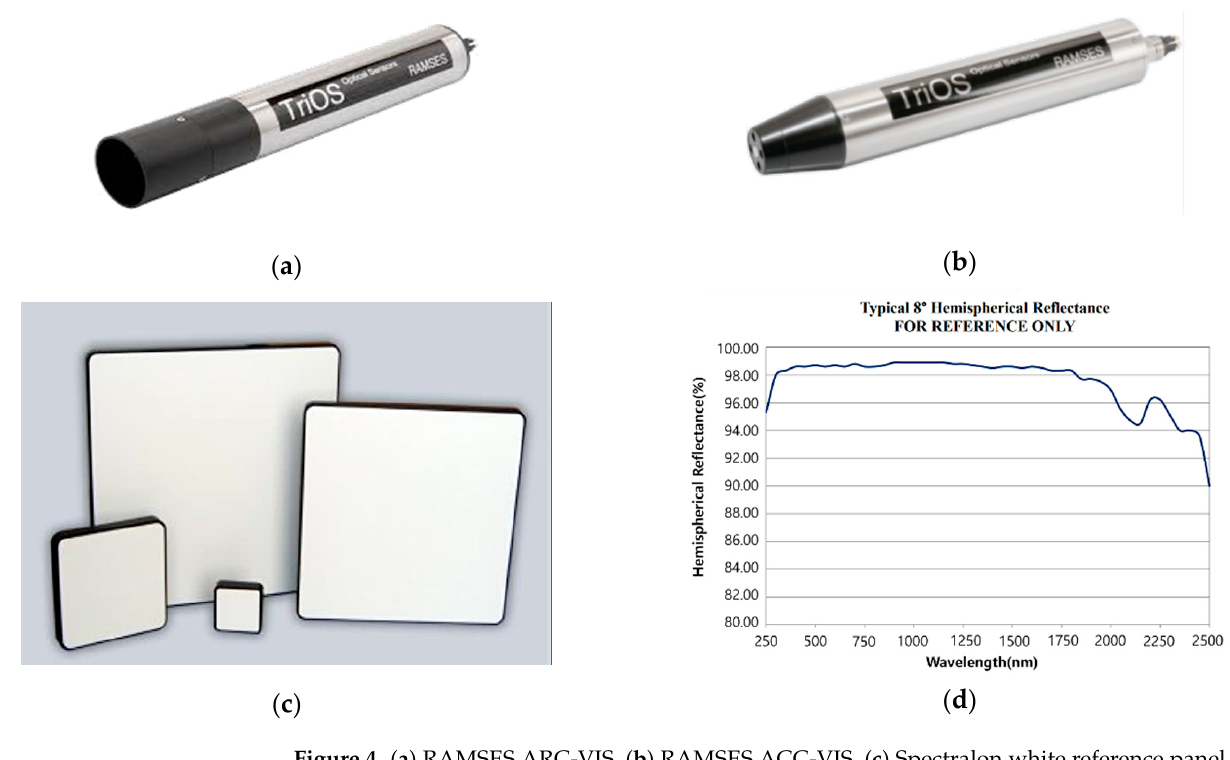
Figure 4. ( a ) RAMSES ARC-VIS, ( b ) RAMSES ACC-VIS, ( c ) Spectralon white reference panel, and ( d ) reflectance of the white reference panel.